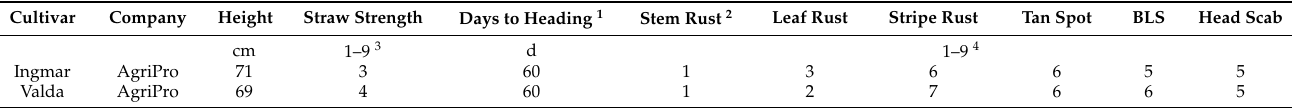
Table 2. Agronomic characteristics of the two cultivars included in the experiment.